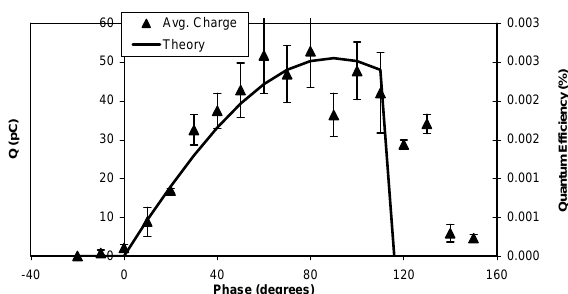
FIG. 7. Average charge versus laser injection phase demon- strating the Schottky effect. The average laser energy for this scan was about 10 m J, corresponding to a peak quantum effi- ciency, h , of about 2.5 3 10 2 5 .